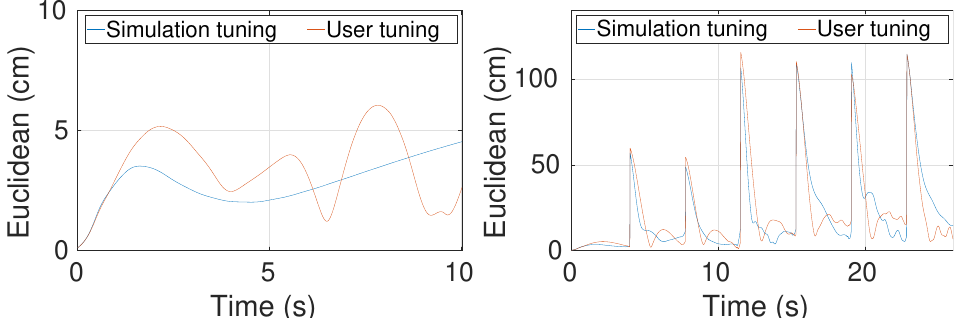
Figure 7. Euclidean errors for hover ( left ) and for sequential setpoints ( right ) by the best weight sets from simulation and user-based